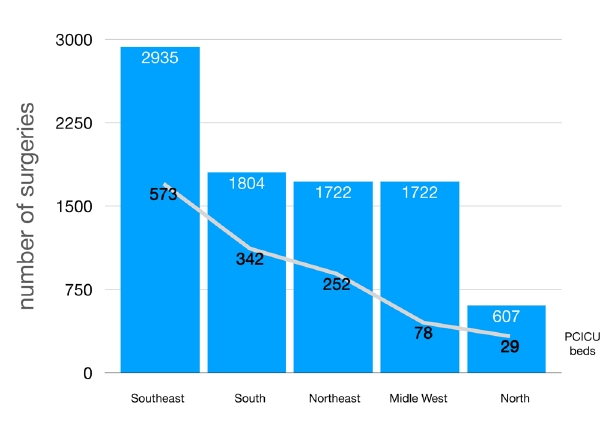
Fig. 3 – Number of surgeries per region compared to availability of pediatric cardiac intensive care unit (PCICU)